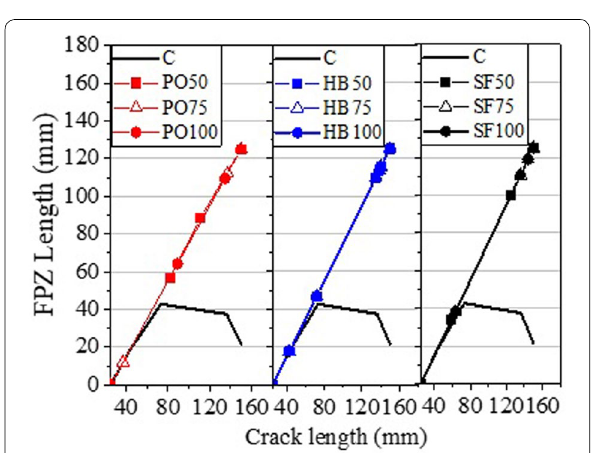
Fig. 18 Variation of FPZ length in FRC